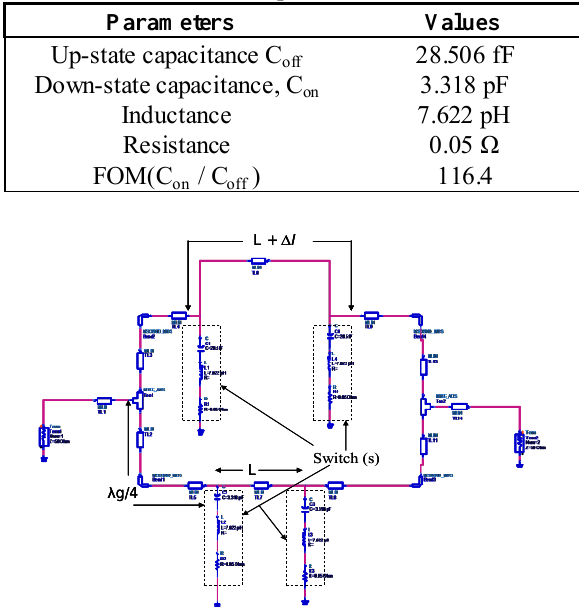
Figure 10: Equivalent ckt. of the single bit phase